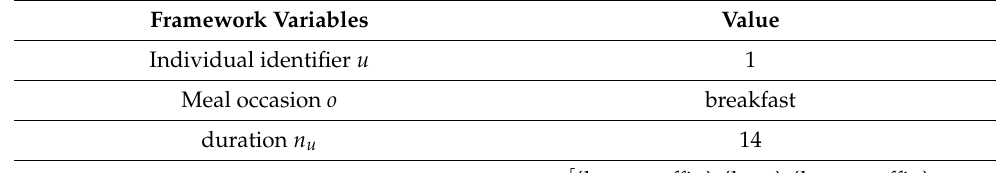
Table 2. Computed values for the